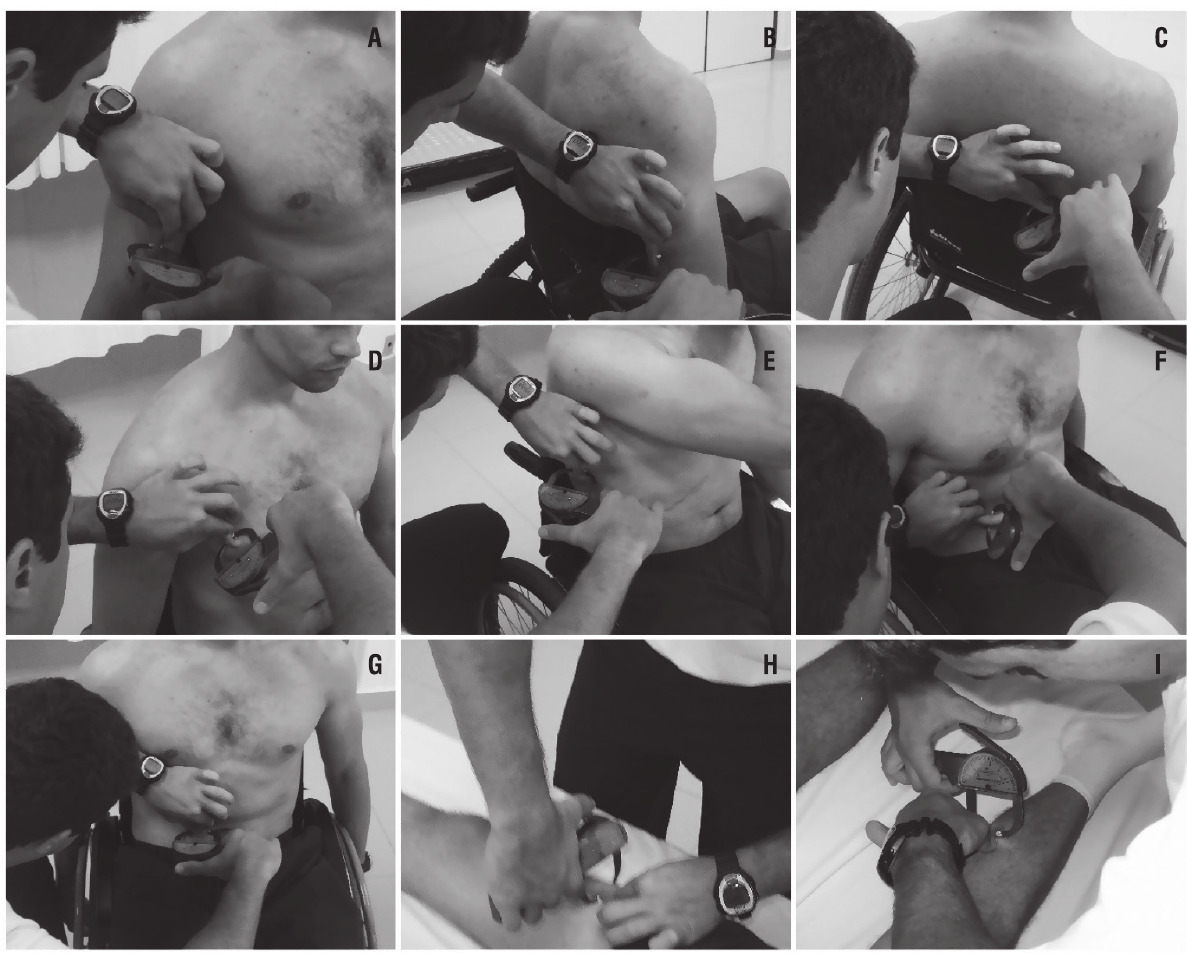
Figure 1 - Standardization of positioning to measure the skinfolds Legend: A= Biceps; B= Triceps; C= Subscapular; D= Pectoral; E= Mid axillary; F= Suprailiac; G= Abdominal; H= Thigh; I. Leg. Source: Research